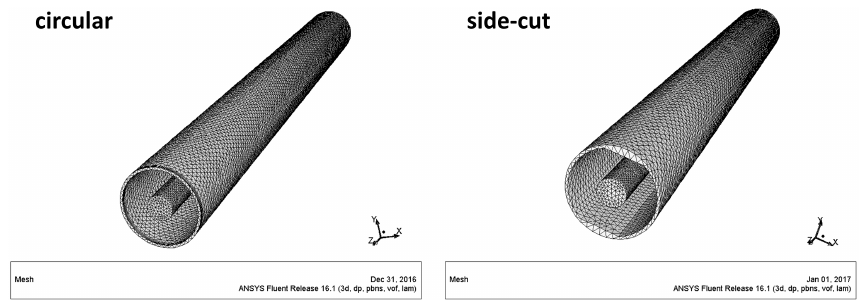
Figure 5. Meshed models representing the geometry at flushing gap.